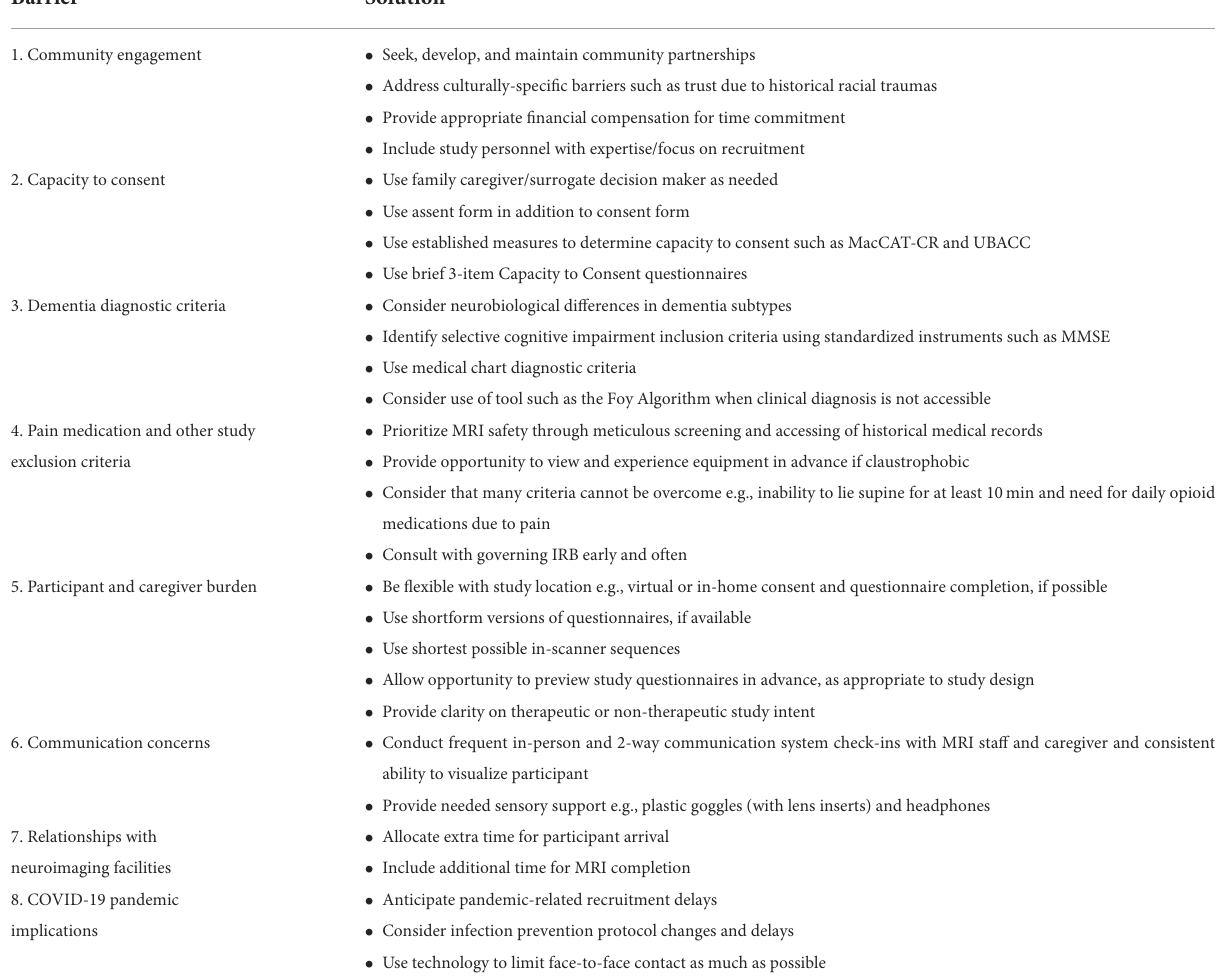
TABLE 1 Barriers and solutions for recruiting persons living with ADRD for pain-related neuroimaging